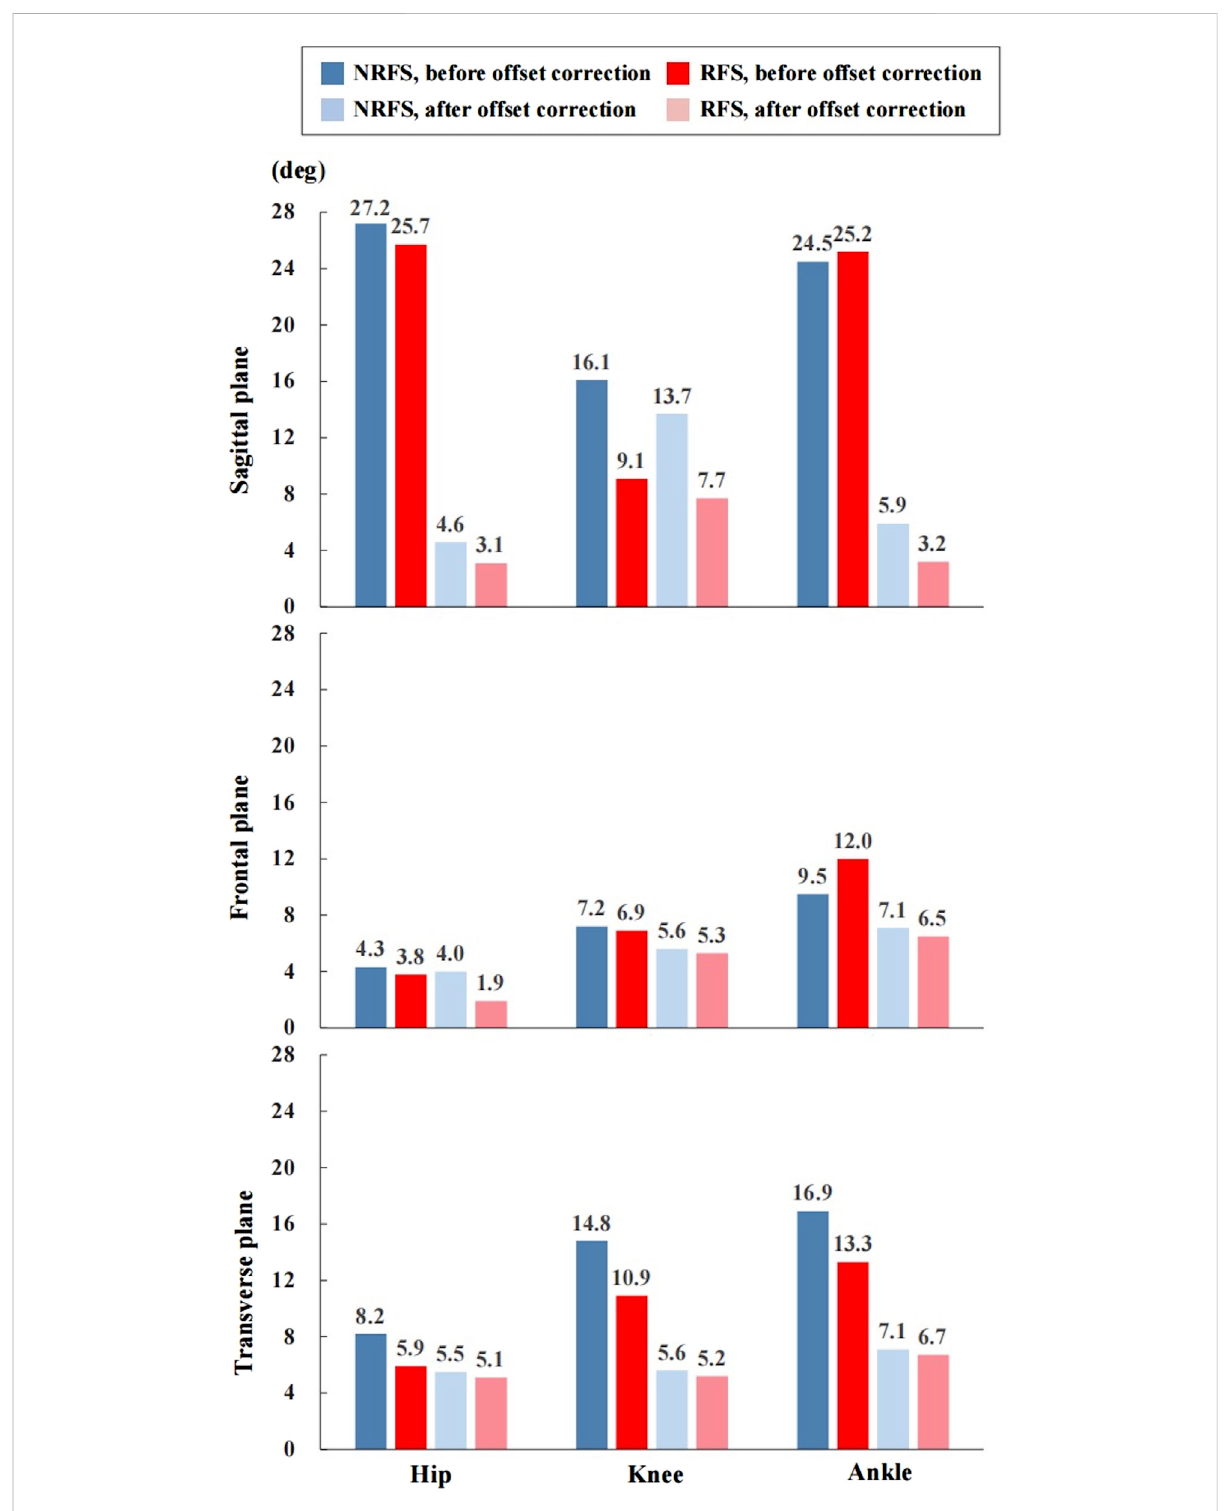
FIGURE 5 The root mean square error of the joint angle waveforms between the inertial measurement units system and optical reference system. NRFS non-rearfoot strike pattern; RFS rearfoot strike